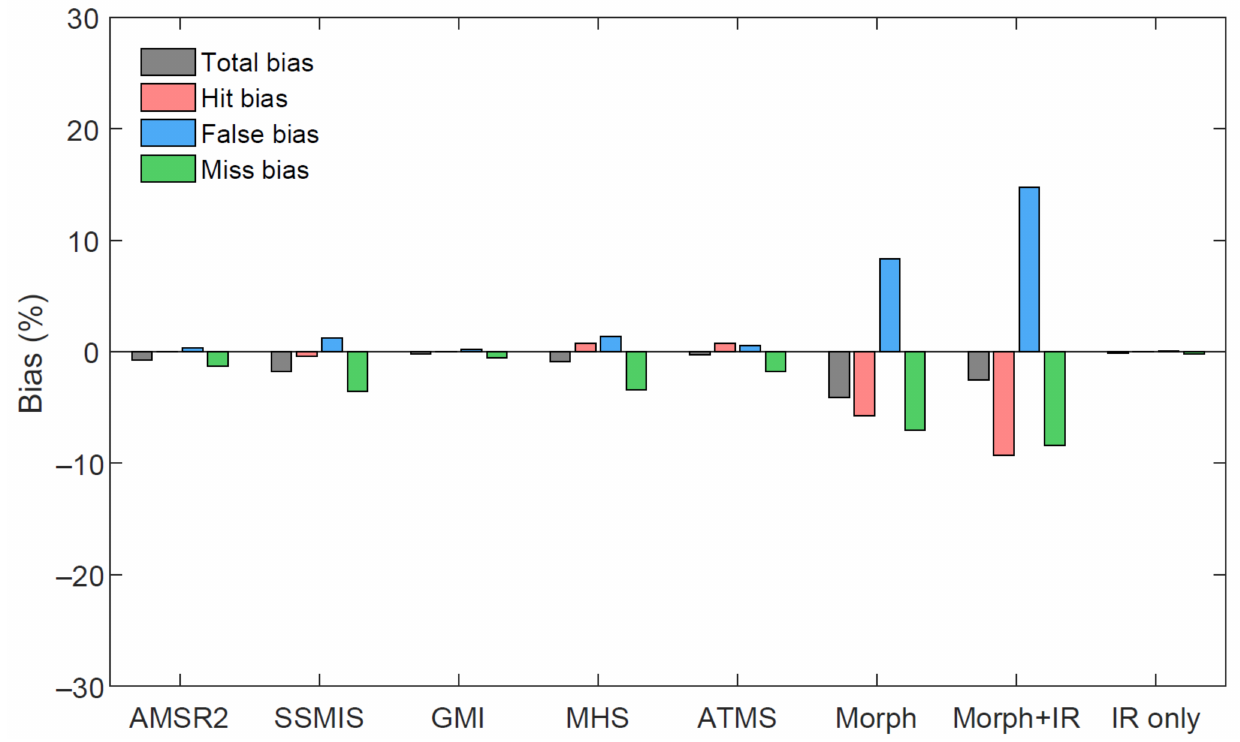
Figure 9. The total bias (TB), hit bias (HB), false bias (FB), and miss bias (MB) components for each input source used in IMERG over the Tunxi